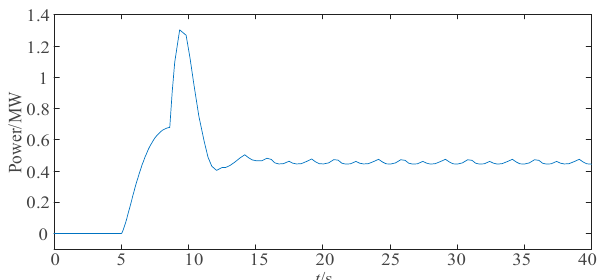
Figure 11. Power change diagram of DFIG.